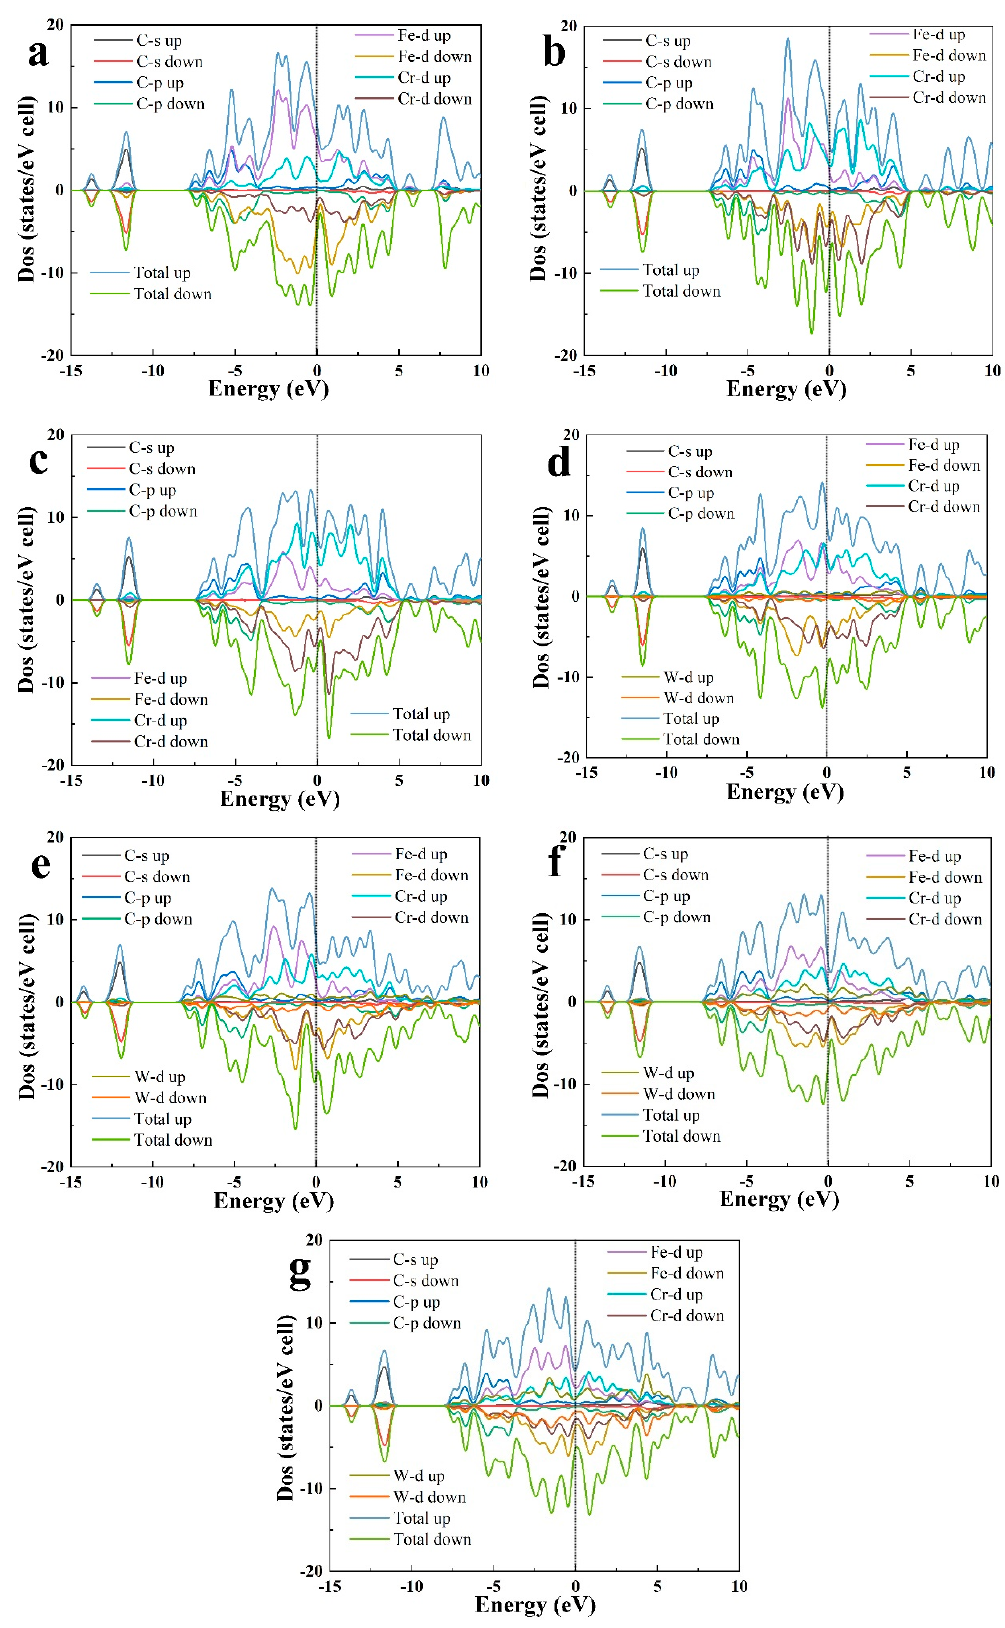
Figure 6. Calculated PDOS: ( a ) Fe 5 Cr 2 C 3 ; ( b ) Fe 3 Cr 4 C 3 ; ( c ) Fe 2 Cr 5 C 3 ; ( d )Fe 3 Cr 3.5 W 0.5 C 3 ; ( e )